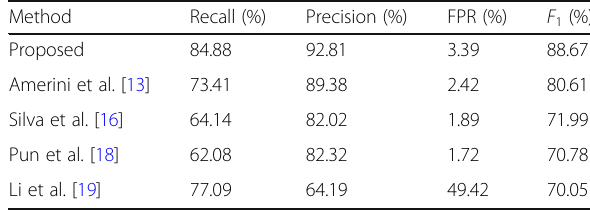
Table 1 Setup for the parameters Parameter Value